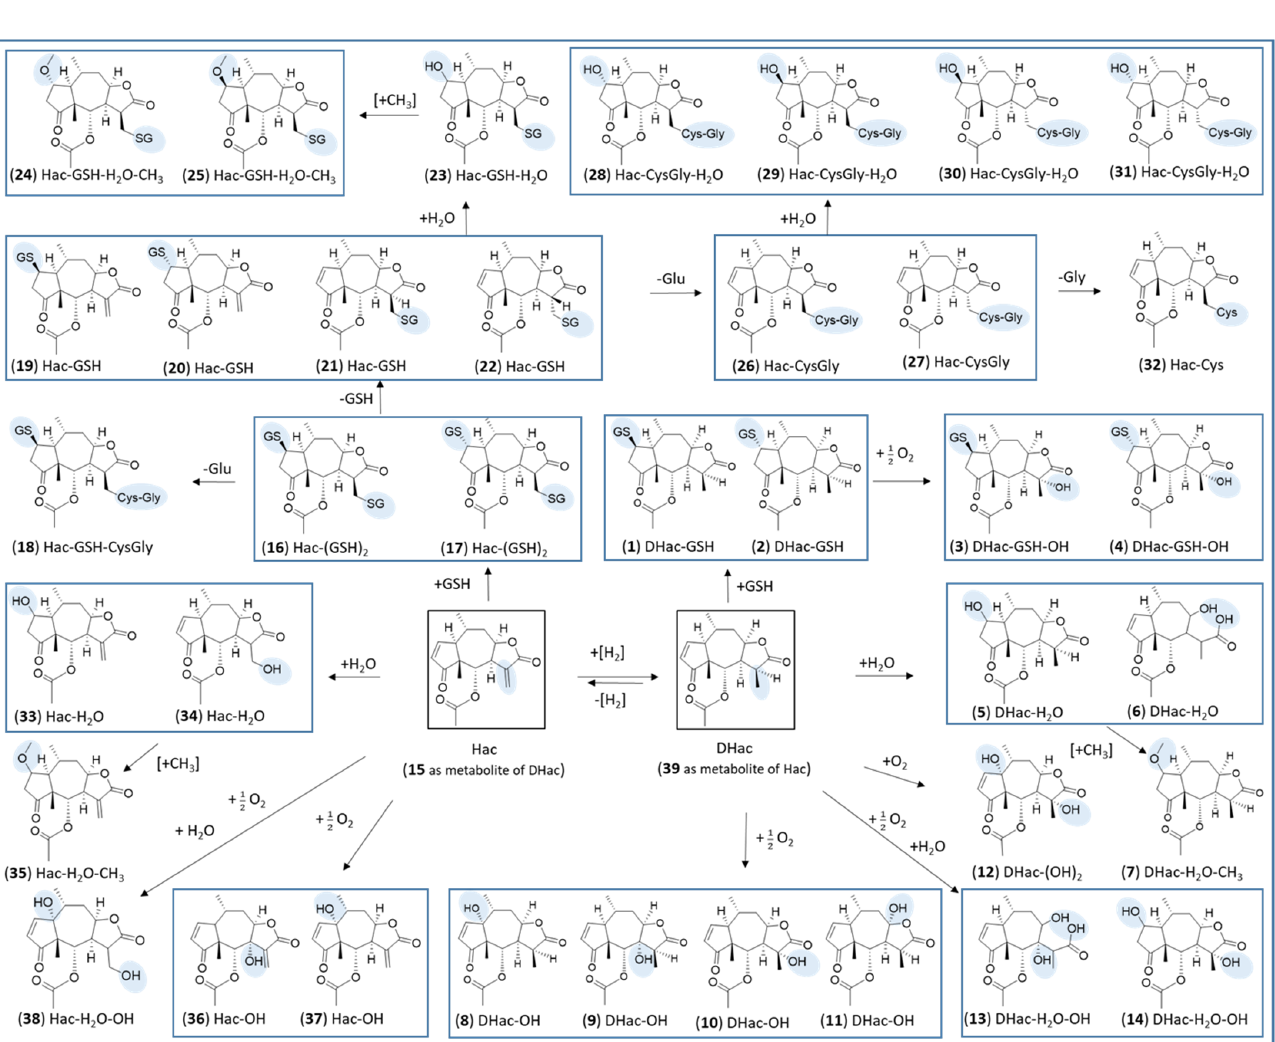
Figure 6. Postulated chemical structures of detected phase I and phase II metabolites of DHac and Hac. Boxes around groups of metabolites indicate the formation by the same biotransformation reaction. Please note that the assignment of relative configuration for the conjugate metabolites based on MS is tentative but based on chemical evidence (cf. Supplementary Materials).